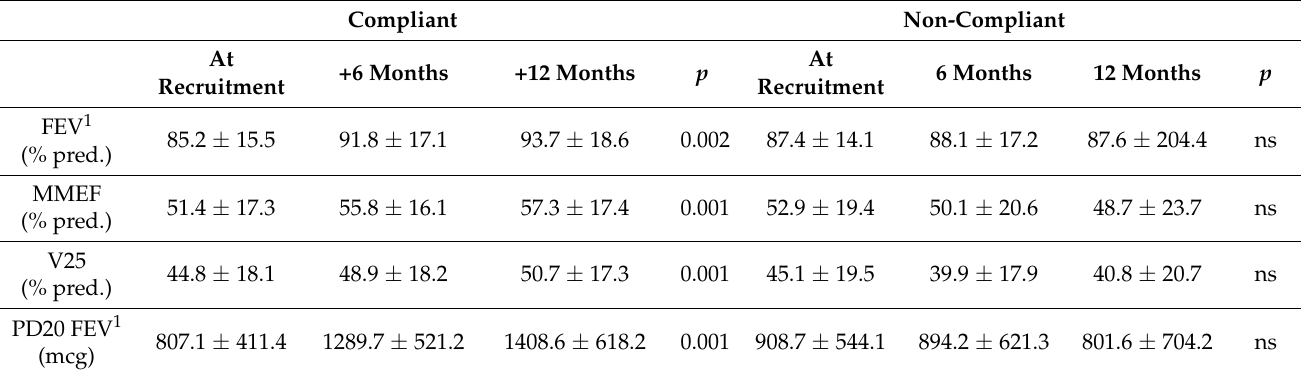
Table 2. Mean values (means ± sd) of lung function parameters assessed at recruitment, and after 6 and 12 months of the study, in compliant and non-compliant adolescents. Statistical comparisons (ANOVA) and corresponding levels of significance are shown.